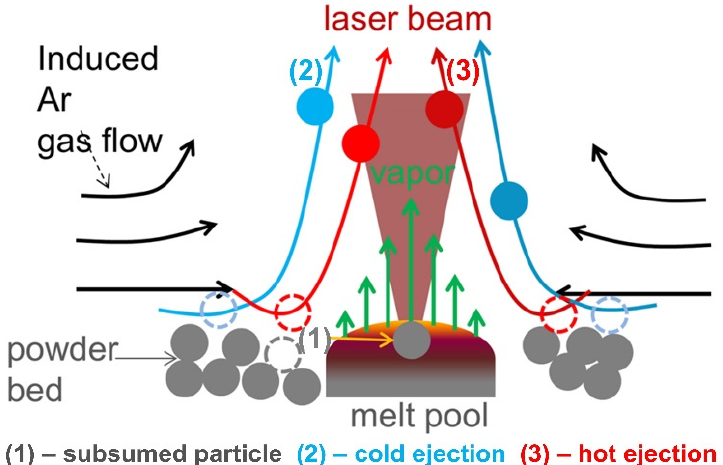
Figure 9. Schematic representation of the entrainment effect of metal-vapor-driven airflow on fine particles in the presence of a fixed laser beam. A vapor jet creates a zone of low pressure, which results in three different trajectories of entrained particles: (1) Particles with low vertical momentum are swept into the melt pool; (2) Particles with higher vertical momentum but originating > 2 melt pool widths away are swept into the trailing portion of the vapor jet, and ejected as cold particles; (3) particles with roughly the same vertical momentum as (2) but originating closer to the point of laser irradiation (<2 melt pool widths) are swept into or near the laser beam itself rapidly heat, and are ejected as incandescent, hot particles. (Reprinted with permission from Ref. [64]. Copyright 2017 Springer Nature.).